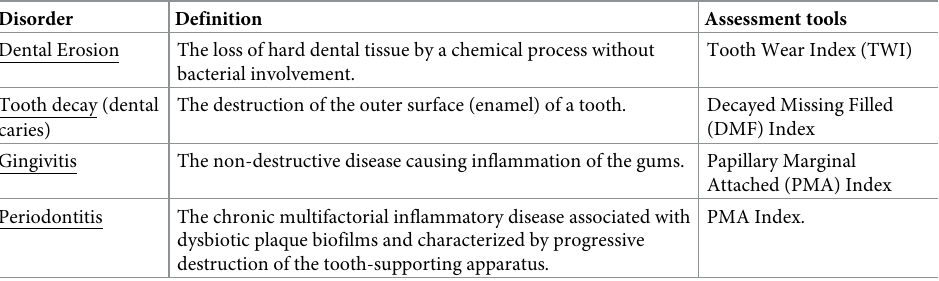
Table 1. Definitions of dental disorders included in the present